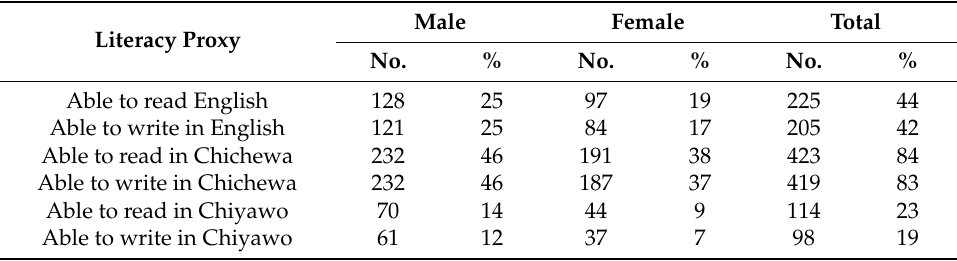
Table 3. Literacy levels of people in fishing villages (2017) N =